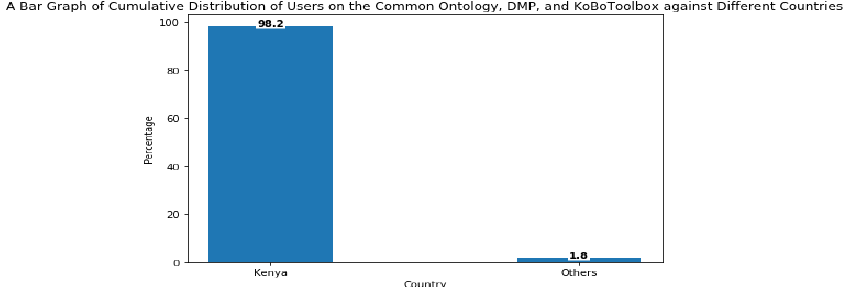
Figure 11. Cumulative distribution of users on the common ontology, DMP, and KoBoToolbox against different